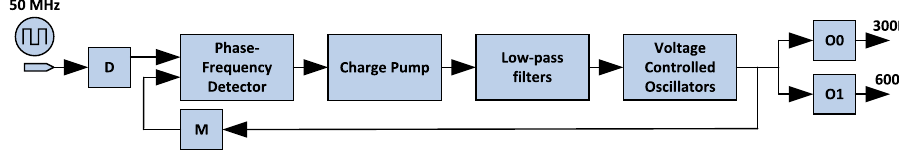
Figure 12. Clock domain generation block